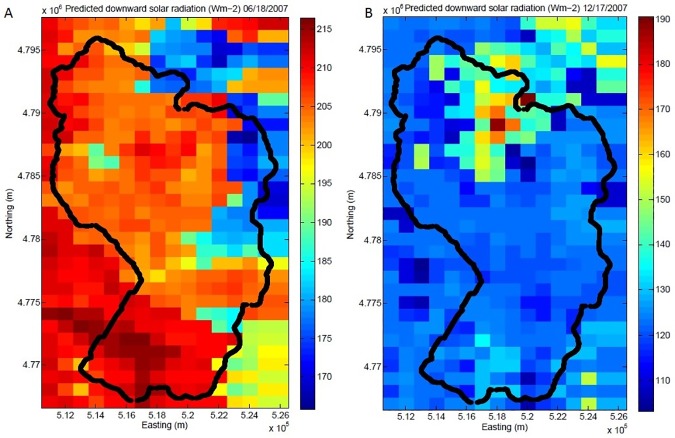
The spatiotemporal pattern of downward solar radiation (W/m2/day) for RCEW on June, 18th (A) and on December, 17th (B) in 2007.